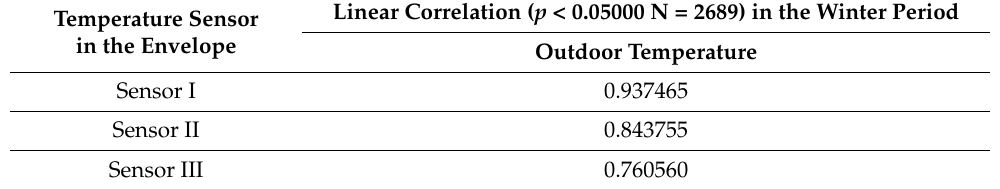
Table 5. Linear correlation between the temperature inside the building envelope and the outdoor